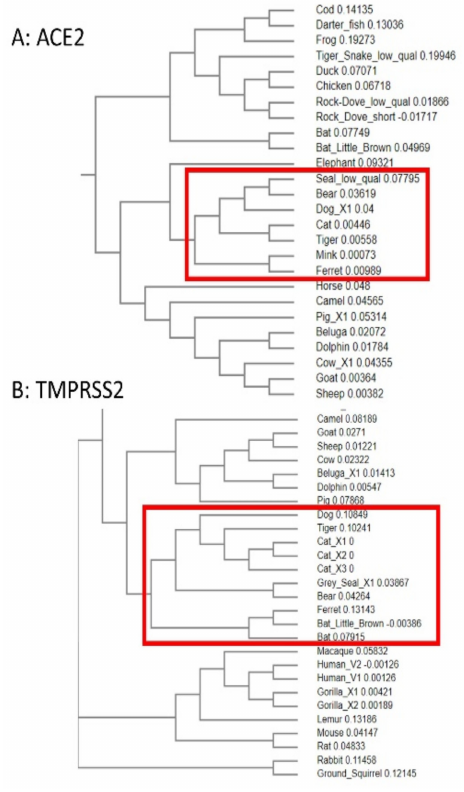
Figure 7. Phylogenetic analysis of the animals using the alignment sequences. Sequences as listed in Table 1 were analysed by Clustal Omega [45] and then relevant sections of the phylogenetic analysis shown here. A: analysis of the ACE2 sequences; B: analysis of the TMPRSS2